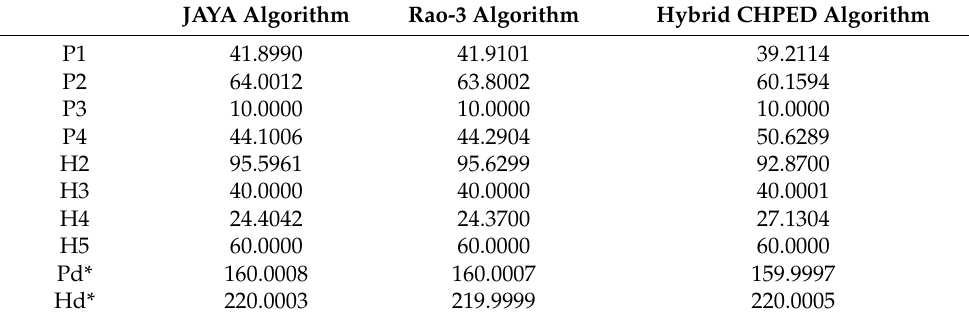
Table 1. Optimised values of the power-heat production of test system 1.